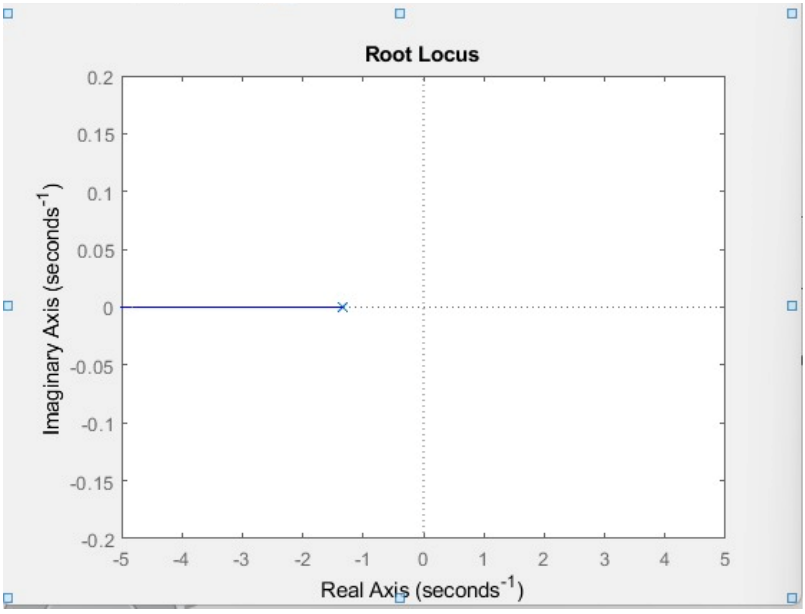
Table 2. Validation table for the results obtained.